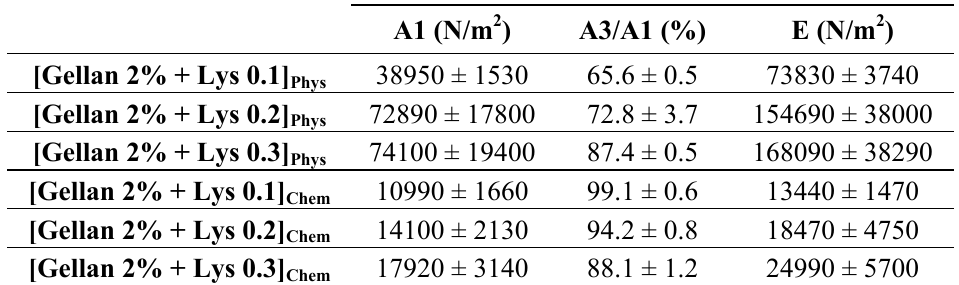
Table 3. Values of the area under the  N = f(  ) curve, A1, compressibility, A3/A1, and Young Modulus, E for the tested hydrogels (25